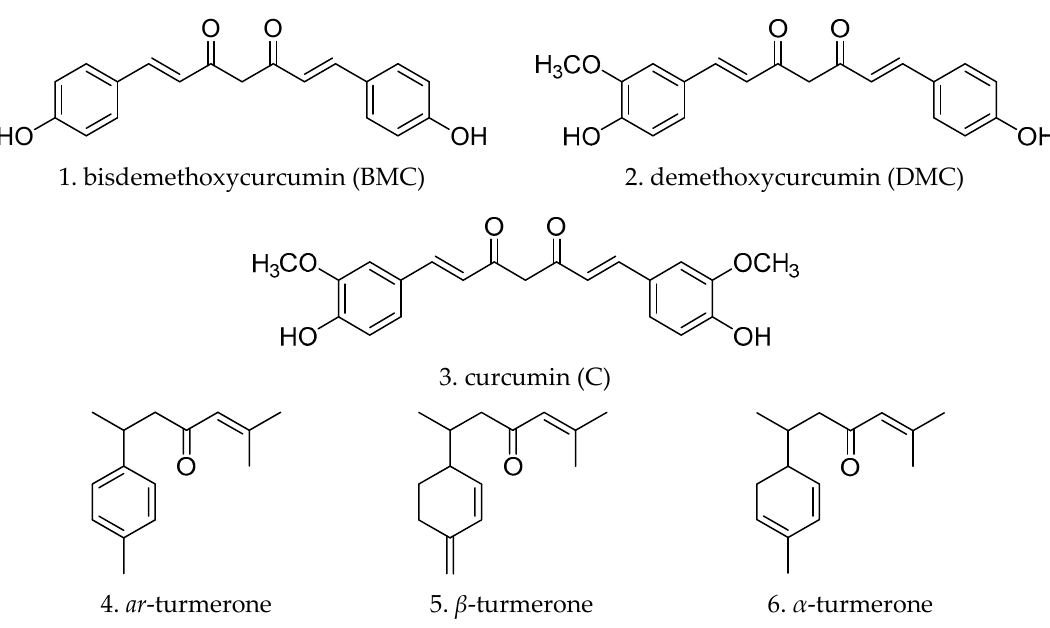
Figure 1. Structures of three curcuminoids and three volatile compounds in turmeric.